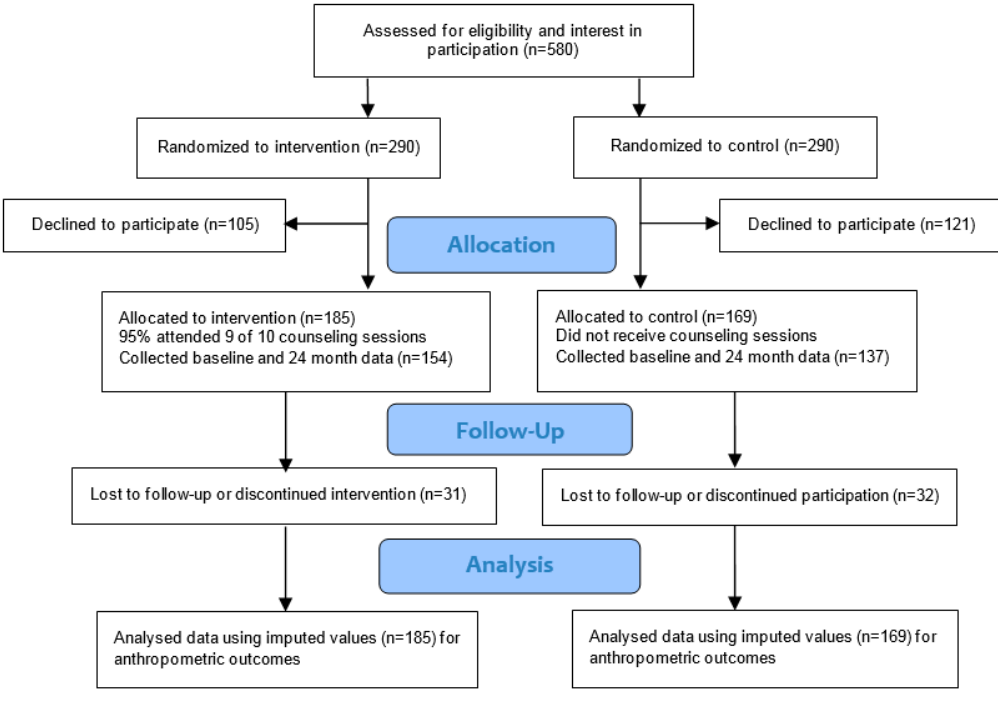
Figure 1. Flow diagram for midlife women participating in a weight gain prevention study by intervention and control group.